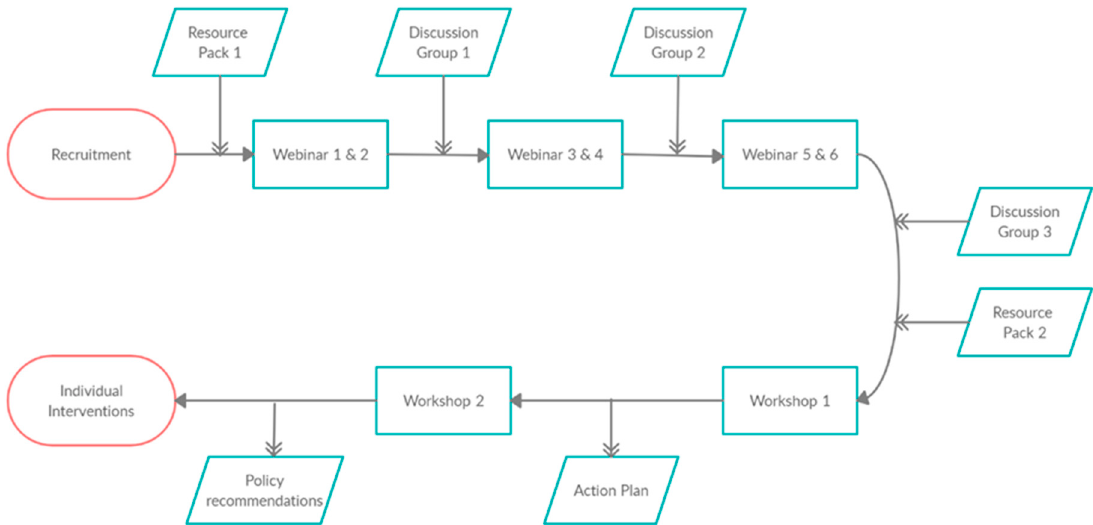
Figure 1. Flowchart showing the chronology of the inputs and outputs in the Arwain Vet Cymru programme.